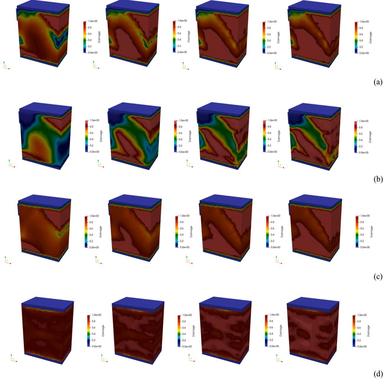
Wall#1 (a), Wall#2 (b), Wall#3 (c) and Wall#4 (d) damage evolution for the 25%, 50%, 75% and 100% of the Fmax (macro-modelling approach).